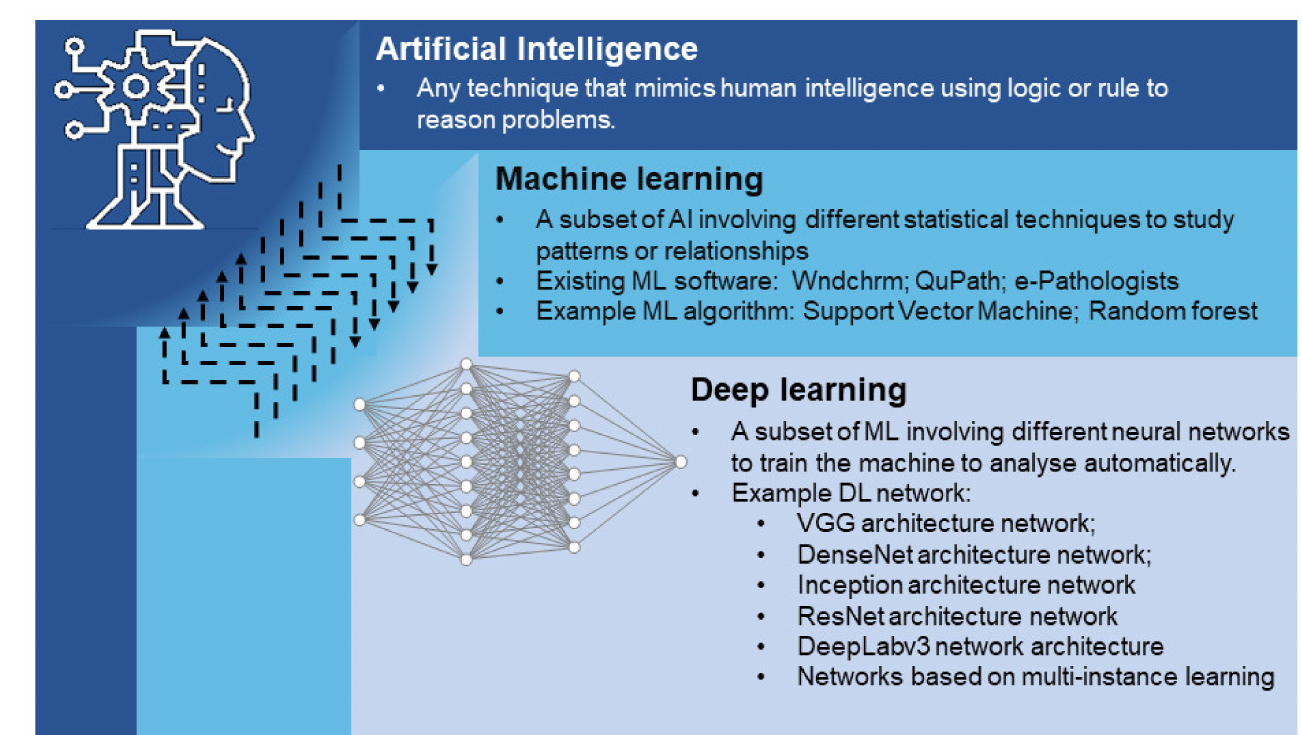
Figure 2. Overview of AI techniques and algorithm development in computational pathology for GI cancers. AI is a concept that mimics human intelligence with respect to learning and problem solving. Deep learning is a subset of machine learning; both are techniques used for the development of AI to study the patterns or relationships in WSIs. Deep learning-based techniques are capable of automatic feature extraction, whereas machine-learning-based techniques require manually designed features. Existing software, algorithms and network architectures discussed in this study are summarized in the